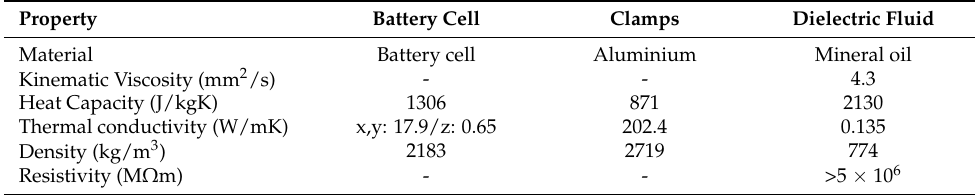
Table 1. Properties of the battery cell, the clamps, and the dielectric fluid, for 25 ◦ C.